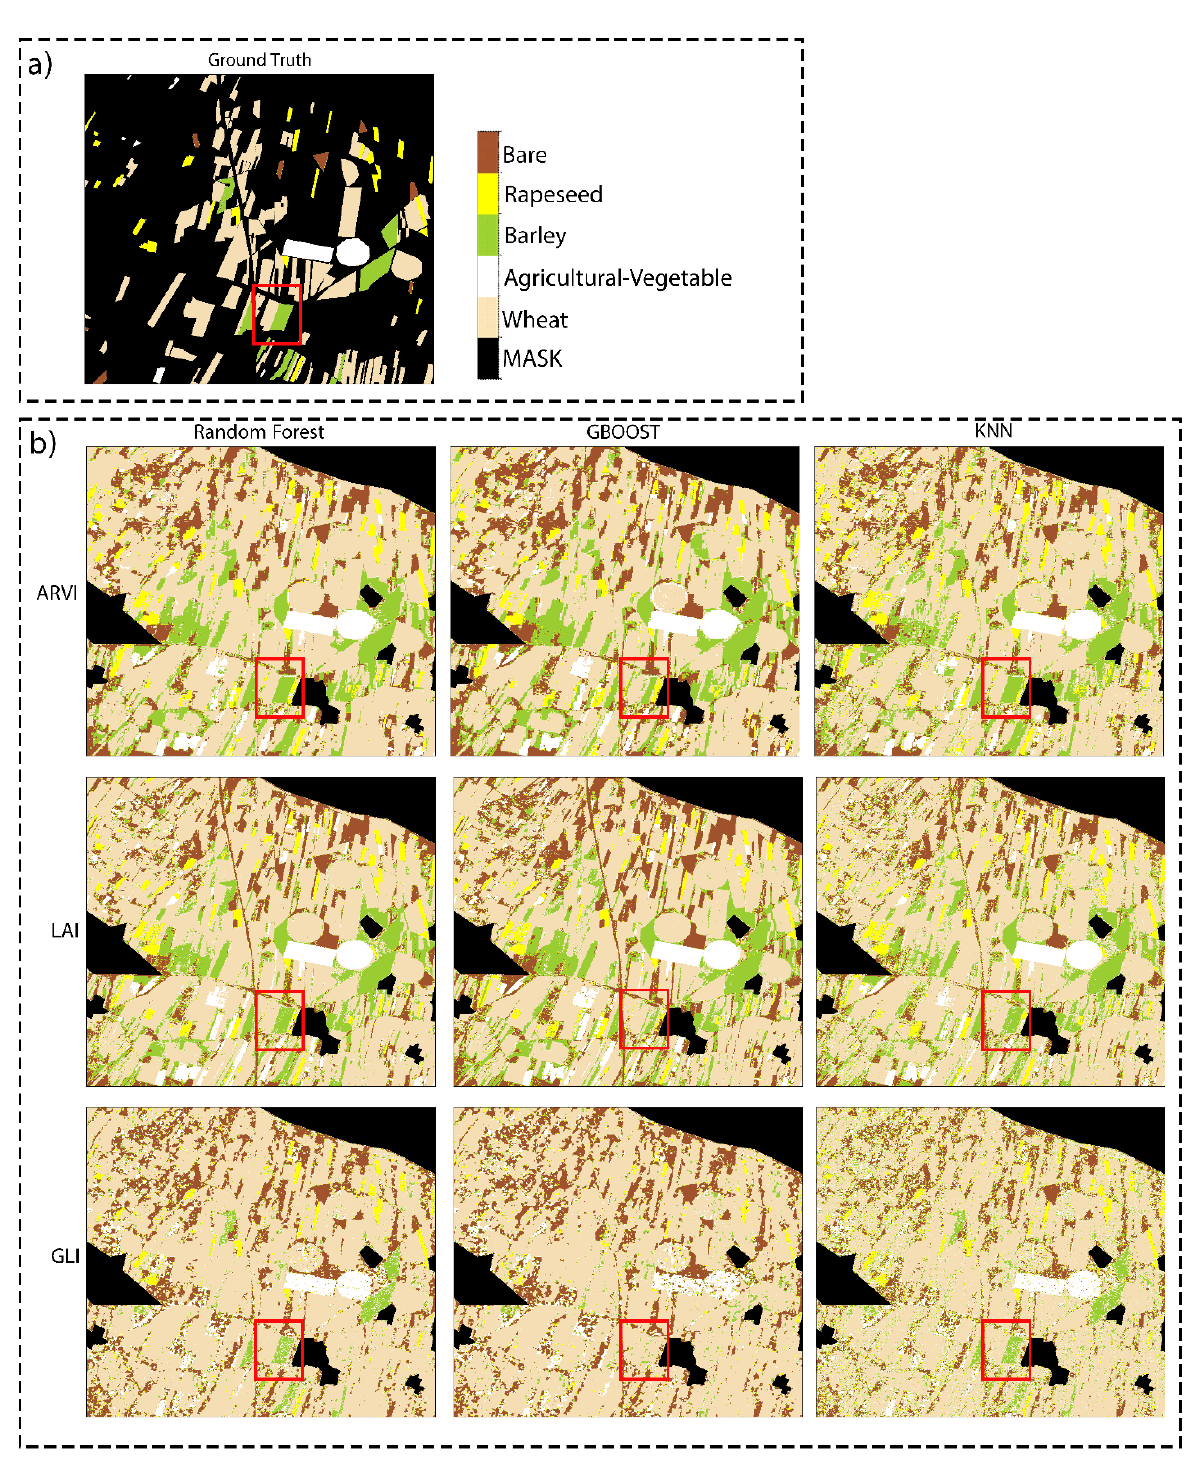
Figure 4 . Comparison of the result of crop mapping using three algorithms (RF, GB, KNN) with ARVI, LAI, and GLI inputs. The red boxes indicate the same locations to further visual analysis. a) Collected in-situ data as ground truth, b) crop maps produced using ML methods and